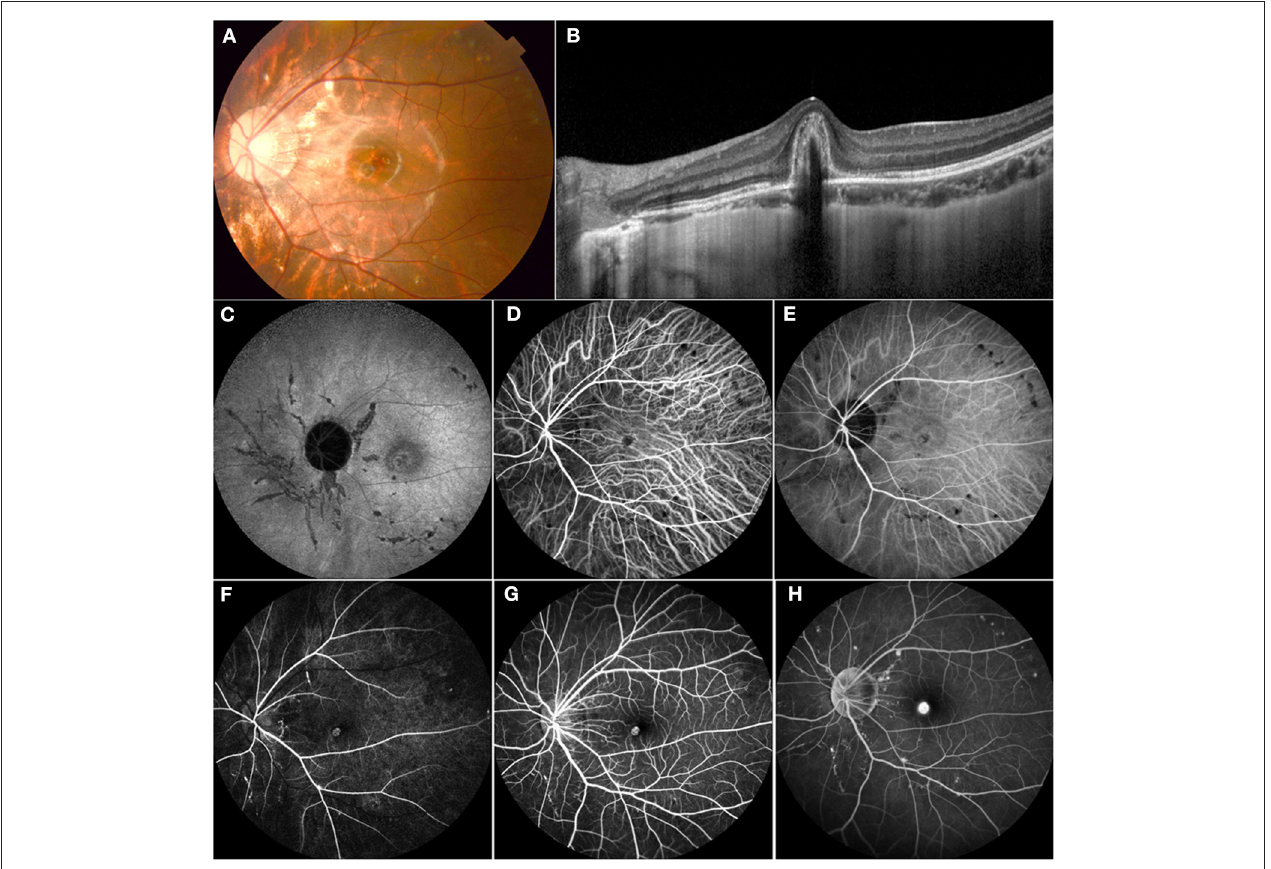
FIGURE 4 | Multimodal imaging of an 11-year-old female who presented with decreasing vision in her left eye. Her BCVA was 0.3 logMAR with a refraction of − 6.00 – 1.50*5 in the left eye and 0.9 logMAR with a refraction of − 5.5 – 1.25*177 in the right eye. (A) Color fundus demonstrated mottled fundus, lacquer cracks, and myopia conus. (B) OCT showed a subretinal high-refractive material with fuzzy margins and the absence of the inner segment/outer segment junction. (C) FAF showed hypofluorescence secondary to mechanical linear breaks in the elastic layer of the Bruch membrane. (D,E) ICGA showed an abnormal vascular network and hypofluorescence corresponding to the areas of LC. (F–H) FFA demonstrated hyperfluorescence in the early phase and leakage in the late phase of CNV and a hyperfluorescence linear area consistent with LC. This patient received 1 intravitreal injection of ranibizumab, and the vision was stable at 0.3 at